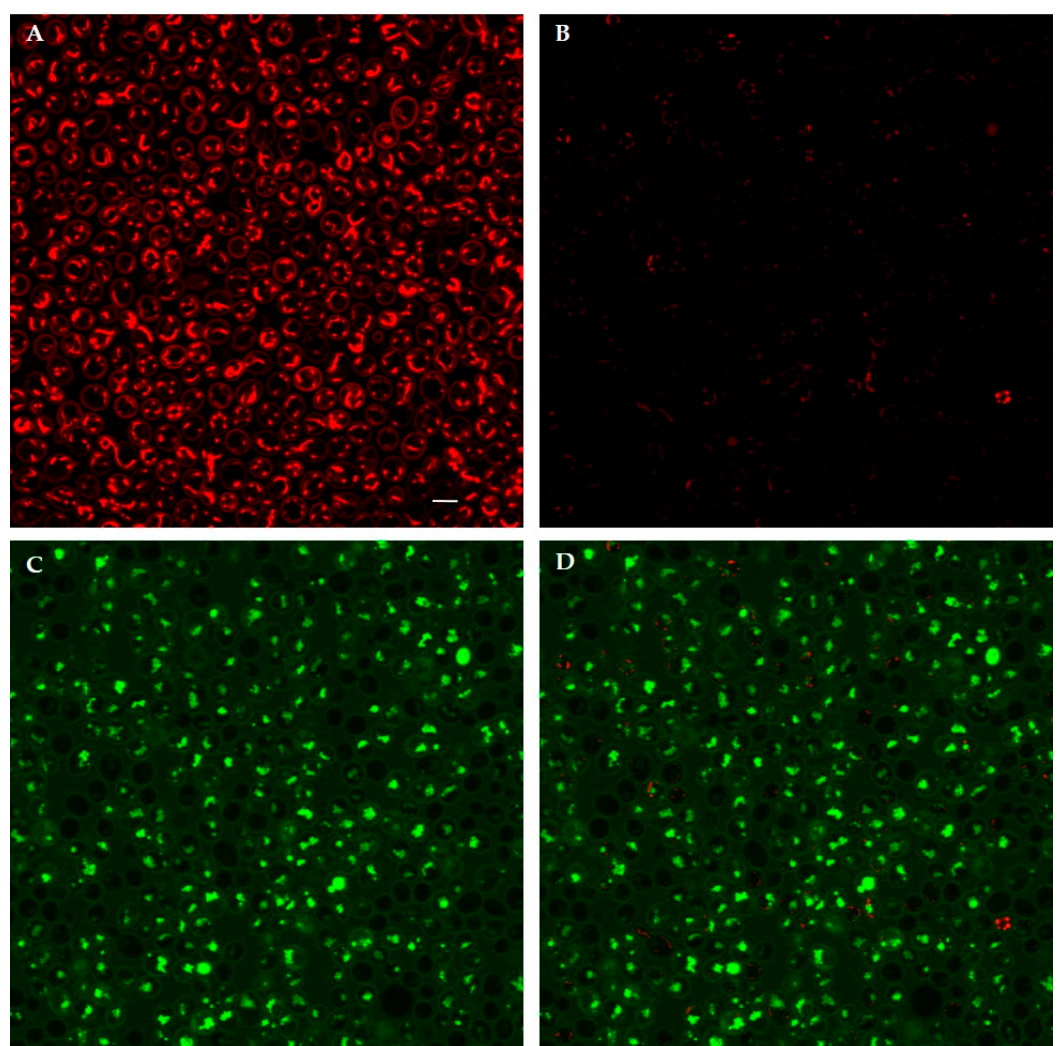
Figure 12. Confocal images of living Candida albicans SC5314 cells pre-loaded with TMRM then treated for 30 min with FITC-labeled H10S: ( B ) TMRM; ( C ) FITC; ( D ) merge of ( B , C ), in comparison with untreated (control) cells: ( A ) TMRM. Bar, 5 µm.